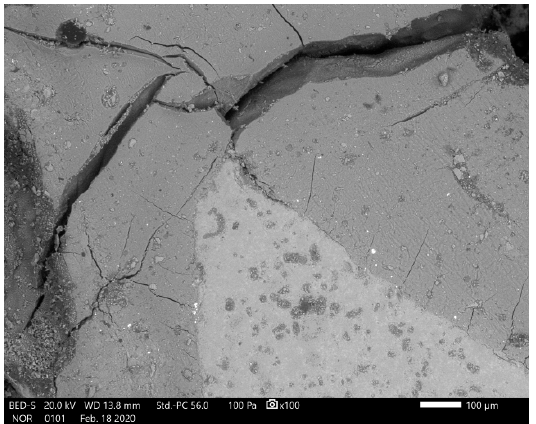
Figure 7. SEM micrograph of alkali activated material prepared from precursor’s fraction 4 mm < x with magnification of ( a ) 100 and ( b ) 1000. EDXS mapping is presented in (a / b-chemical element) of area (a / b), respectively.